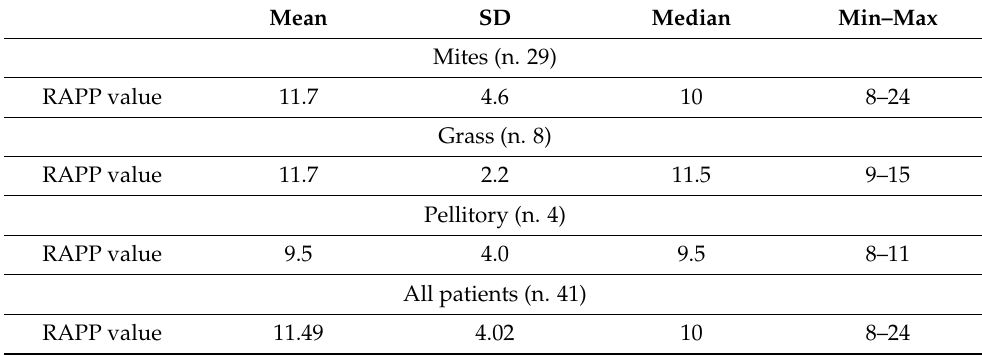
Table 5. RAPP evaluation after treatment in patients with oculorhinitis and asthma.